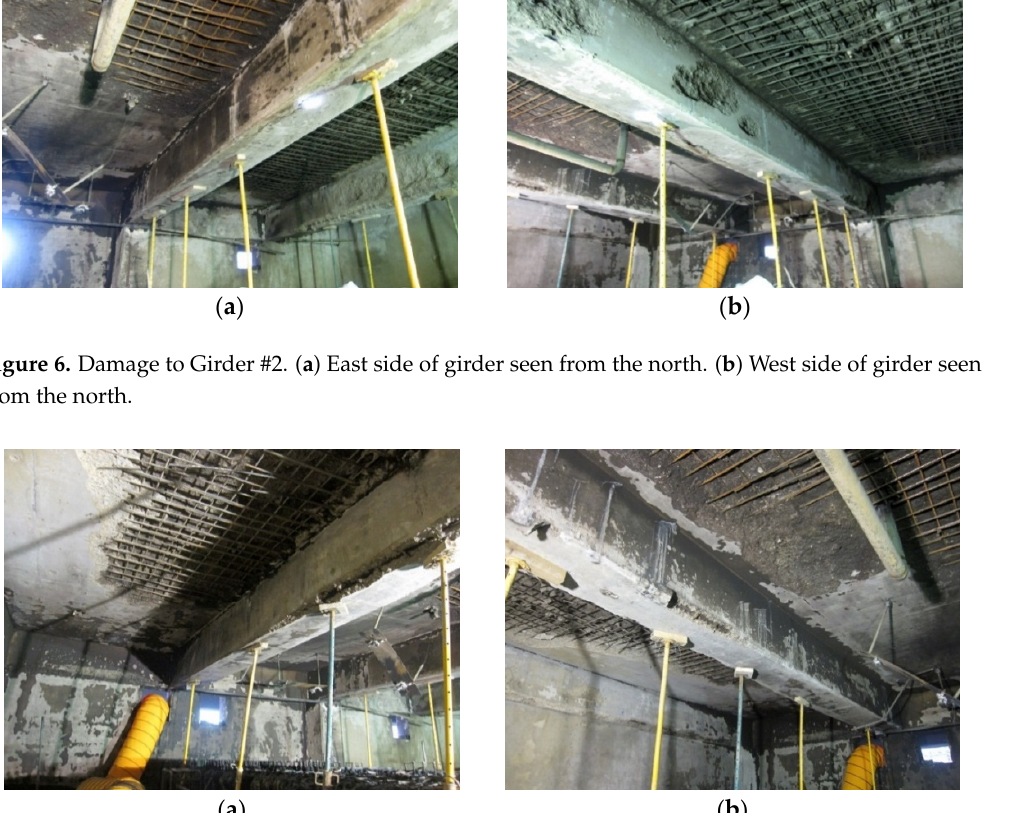
Figure 7. Damage to Beam #1. ( a ) East side of beam seen from the north. ( b ) West side of beam seen from the north.